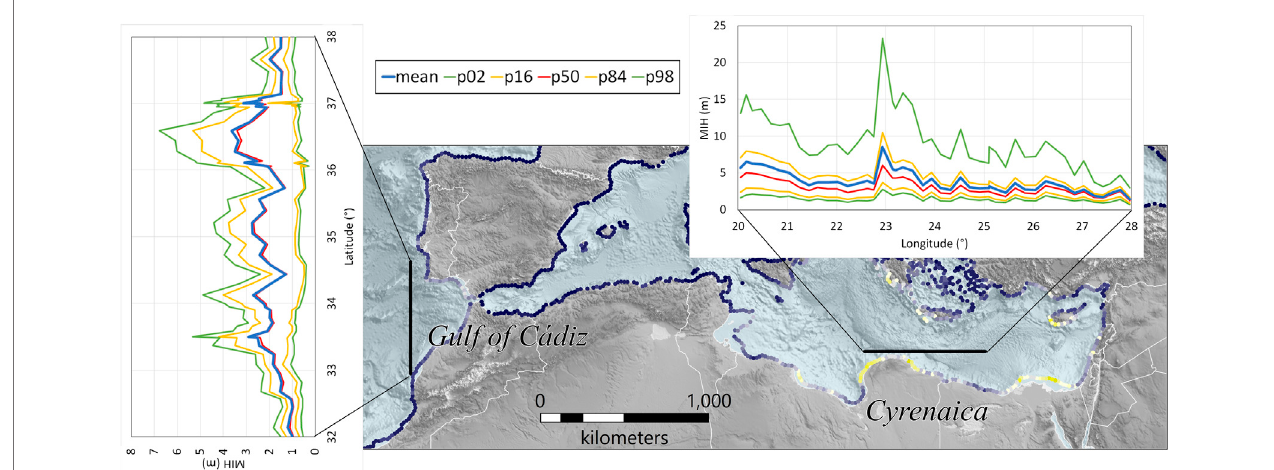
FIGURE 12 | Example pro fi les of the maximum inundation height (MIH; mean and the epistemic uncertainty represented by the 2nd, 16th, 50th, 84th, and 98th percentiles) along coastlines among those with the highest hazard ofthe NEAM Region. The two pro fi les span coast of the Gulf of Cadiz (N – S) and the Cyrenaica (E – W). Bothpro fi lesare withreferencetothehazard modelwiththe 2%probabilityofexceedancein50 years(average return period of2,475 years).Thecolorscaleinthemap is as in Figure 11 . Topo-bathymetry is from the ETOPO1 Global Relief Model (NOAA, 2009; Amante and Eakins, 2009).